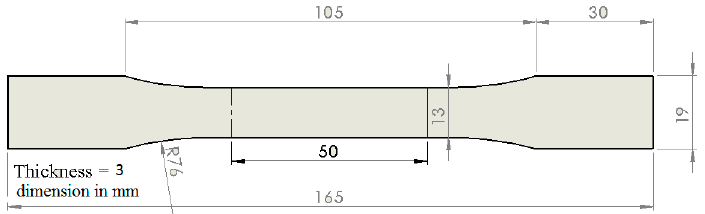
Figure 4. Specification of tensile test specimen according to ASTM D638-14. All dimensions in mm.